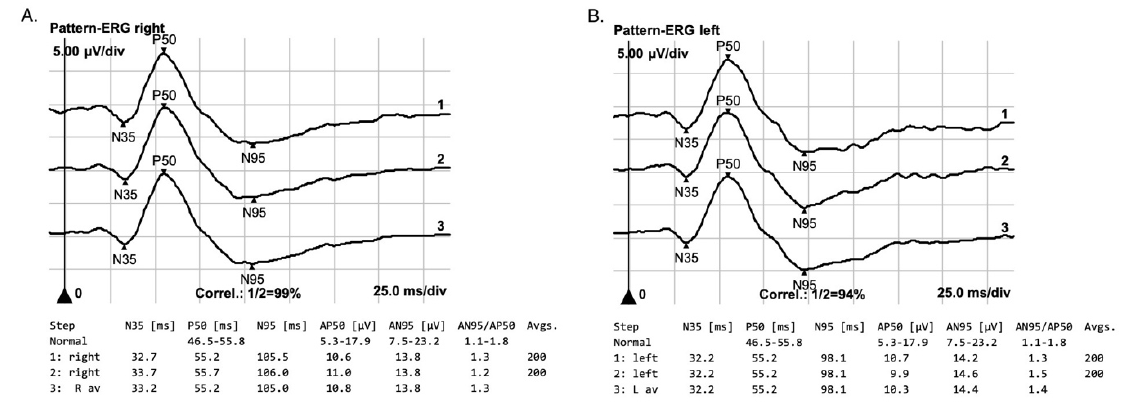
Figure 8. Normal PERG-test results in right eye ( A ) and left eye ( B ).